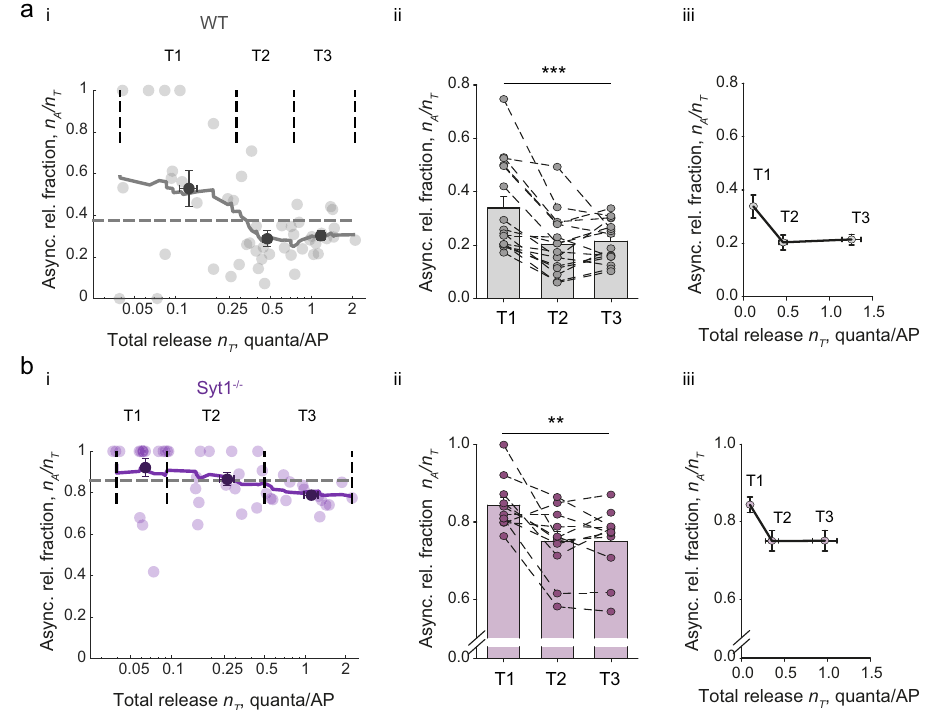
Fig. 3 Asynchronous release fraction is increased in synapses with low release ef fi cacy. a , b Analysis of the heterogeneity in synchronous and asynchronous release among presynaptic outputs of individual wild type (WT) ( a ) and Syt1 − / − ( b ) neurons during a 5 Hz train of 51 action potentials. (i) The relationship between asynchronous release fraction n A / n T and the overall vesicular release ef fi cacy n T among boutons in representative WT ( n = 50 boutons) and Syt1 − / − ( n = 46 boutons) neurons (see also Supplementary Fig. 8 for more examples). Horizontal dashed lines depict the average fractions of asynchronous release in each cell. Continuous lines, moving averages (20 points span). Vertical dashed lines mark the subdivision of boutons into three terciles with low (T1), intermediate (T2) and high (T3) n T values. Black dots with error bars depict average values of n T and n A / n T in each tercile (mean ± SEM). (ii) Bar and dot summary plots showing the increase in asynchronous release fraction in boutons with low n T (mean ± SEM), data from individual cells are connected by dashed lines. (iii) Dependency of n A / n T versus n T averaged among all recorded cells (mean ± SEM). Data are from the same N = 16 wild type and N = 11 Syt1 − / − neurons as in Fig. 2, each recorded neuron contained at least 21 boutons, ** p < 0.01, *** p < 0.001, repeated measures ANOVA (for exact p values, all pairwise multiple comparisons, and further details of statistical analysis see SourceData.xlsx fi n A / n T value (80% con fi dence interval within ±0.15). As each